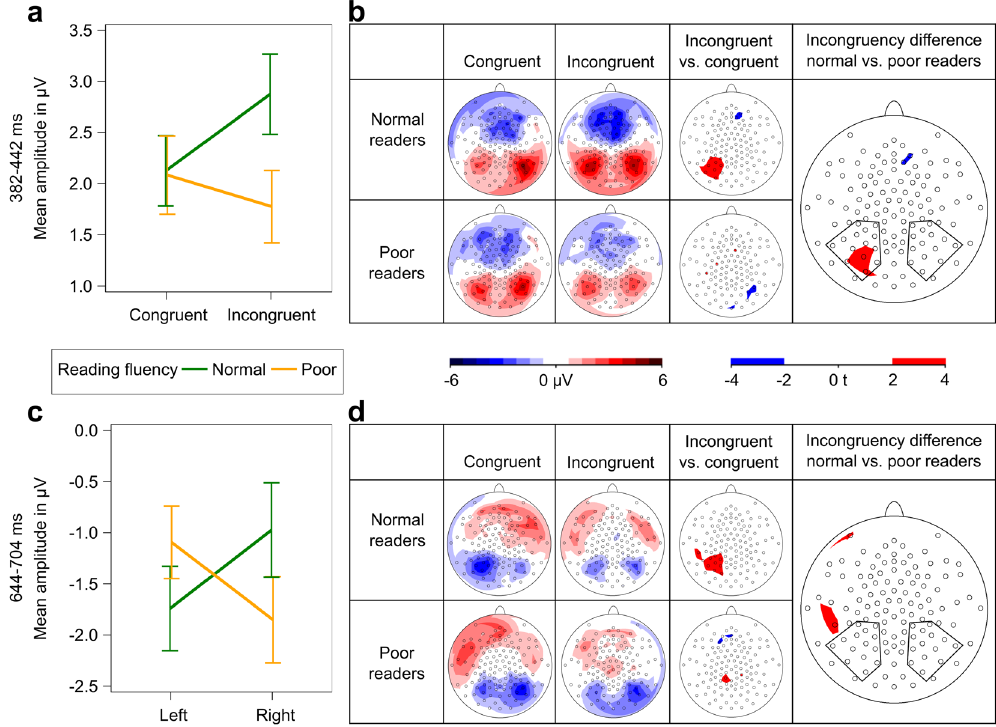
Figure 3. EEG analyses. Mean amplitude values were calculated for electrodes of interest, marked with black polygons ( n = 28). Error bars illustrate standard error of the mean. ( a ) Significant interaction of congruency and reading fluency for mean amplitude values in the time window 382–442 ms. ( b ) Potential field maps and statistical t-maps of initial ERP of audiovisual integration (382–442 ms). ( c ) Significant interaction of hemisphere and reading fluency for mean amplitude values in the time window 644–704 ms. ( d ) Potential field maps and statistical t-maps of late negativity ERP (644–704